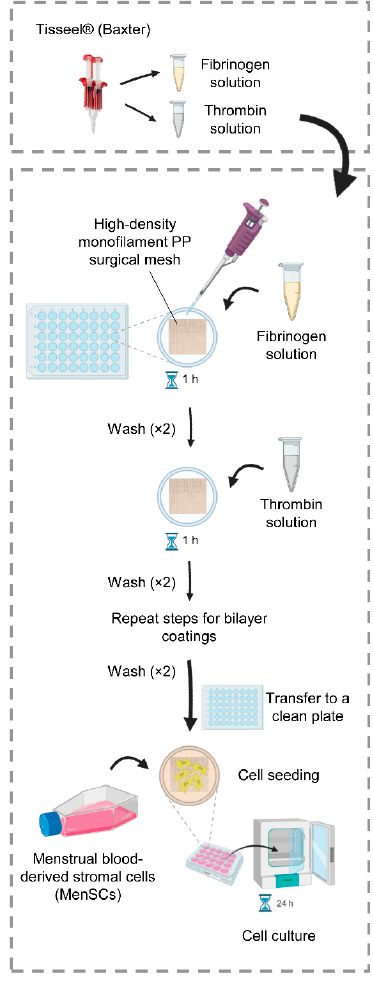
Figure 7. Fibrin coating process of polypropylene (PP) surgical meshes. For each experiment, fibrinogen and thrombin solutions were prepared in PBS or MES buffer. PP surgical meshes, deposited on the bottom of ultra-low attachment multiwell plates, were covered by fibrinogen solutions for 1 h, then rinsed with the proper buffer. Afterward, samples were covered with thrombin solutions for 1 h and rinsed with the proper buffer to obtain monolayered coated meshes. To get bilayered coated meshes, the coating procedure was repeated. For cell seeding, fibrin-coated meshes were transferred to a clean plate and menstrual blood-derived stromal cells were seeded ensuring a complete covering of the mesh and cultured in a cell incubator for 24 h, unless otherwise